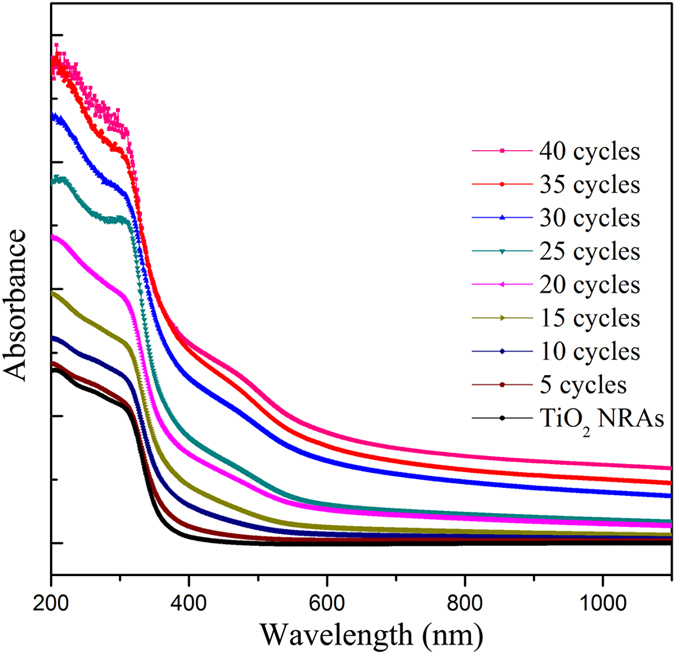
UV-visible absorption spectra of TiO2 NRAs and Ag2S-coupled TiO2 for various cycles.